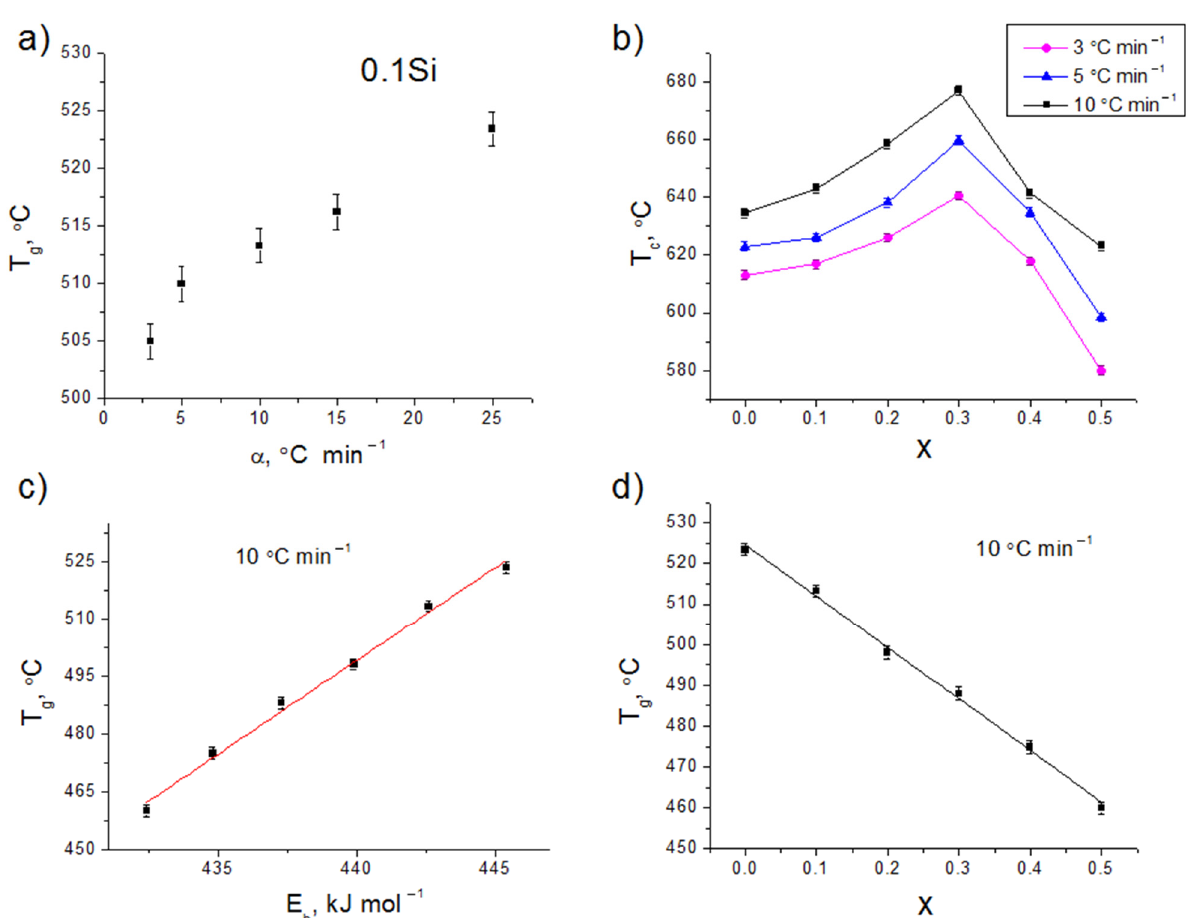
Figure 3. Characteristic temperatures: the glass transition temperatures ( T g ) of the cast 0.1Si glass ( a ) and the crystallization peak onset temperatures ( T c ) of Li 1.5+x Al 0.5 Ge 1.5 Si x P 3 − x O 12 glasses at different heating rates ( b ) and at the rate of 10 °C min − 1 ( c , d ).